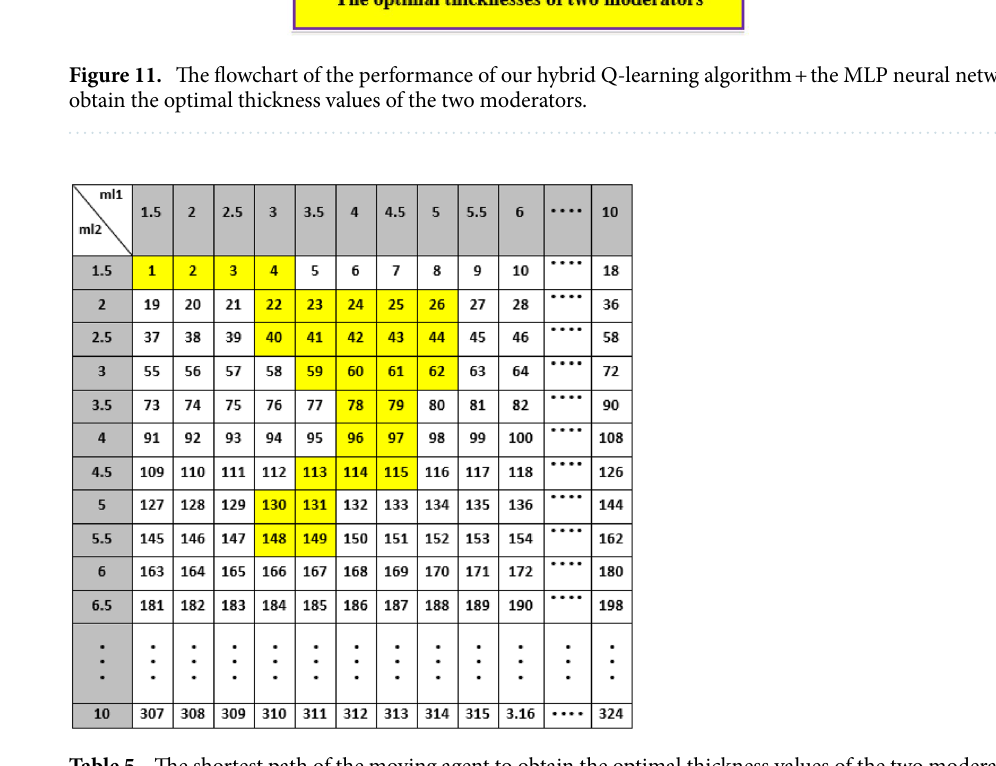
Table 5. The shortest path of the moving agent to obtain the optimal thickness values of the two moderators for the 15 MeV input electron energy at the states